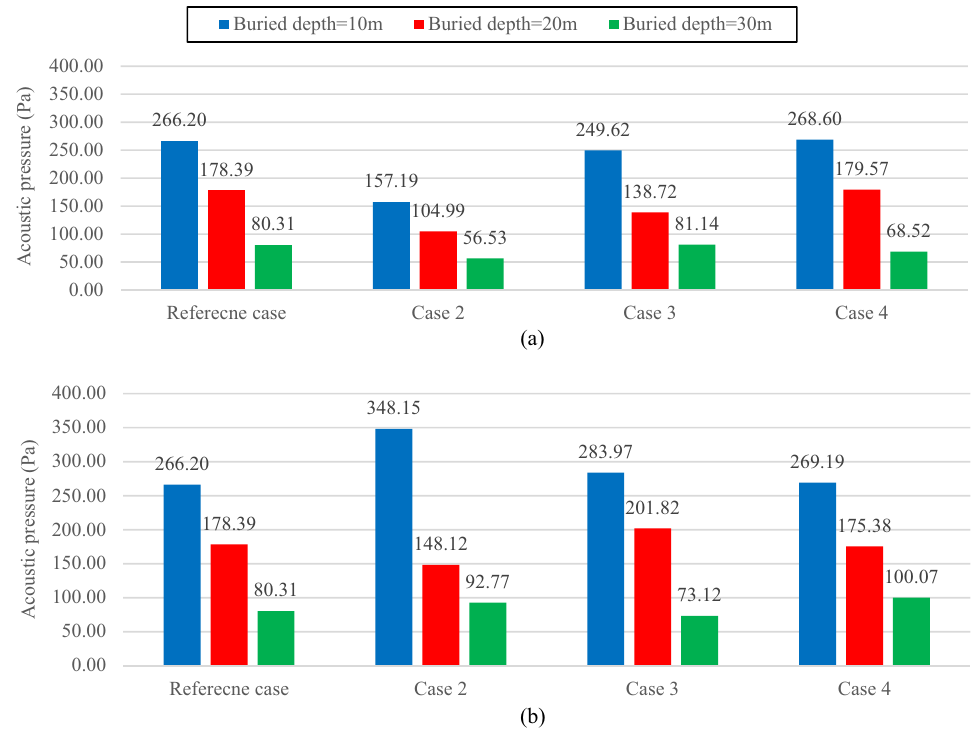
Figure 5. Maximum transmitted acoustic wave pressure for the reference case model alongside the ( a ) stiffer and ( b ) softer soil